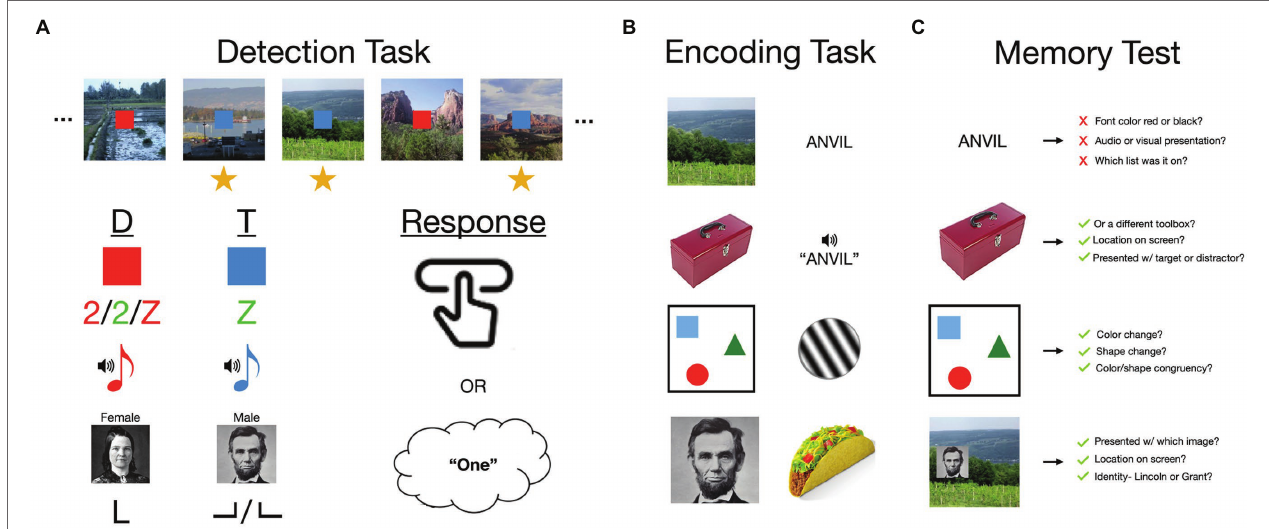
FIGURE 1 | An overview of the attentional boost effect (ABE). (A) The ABE is most frequently demonstrated in a continuous dual-task for which participants memorize individually presented items (e.g., scenes; 500 ms duration; 0 ms interval) and press a button or add to a mental count when a concurrently presented but otherwise unrelated target cue is presented (e.g., a blue square target rather than a red square distractor). Memory for items presented with a target is typically significantly better than that for items paired with distractors. This paradigm has been varied considerably across studies, demonstrating several key features of the ABE: that the ABE occurs for auditory and visual detection stimuli, when targets and distractors are visually similar, and when they are defined by the conjunction of two features. The ABE can also be observed when participants respond by pressing a button, silently counting, or identifying the targets. (B) The ABE or similar effects have also been observed for a variety of stimuli, including short- or long-term memory for scenes, faces, objects, valuable items like food, visually and auditorily presented words, and arrays of colored shapes. Related effects occur in visual habituation to Gabor patches. (C) The ABE sometimes includes